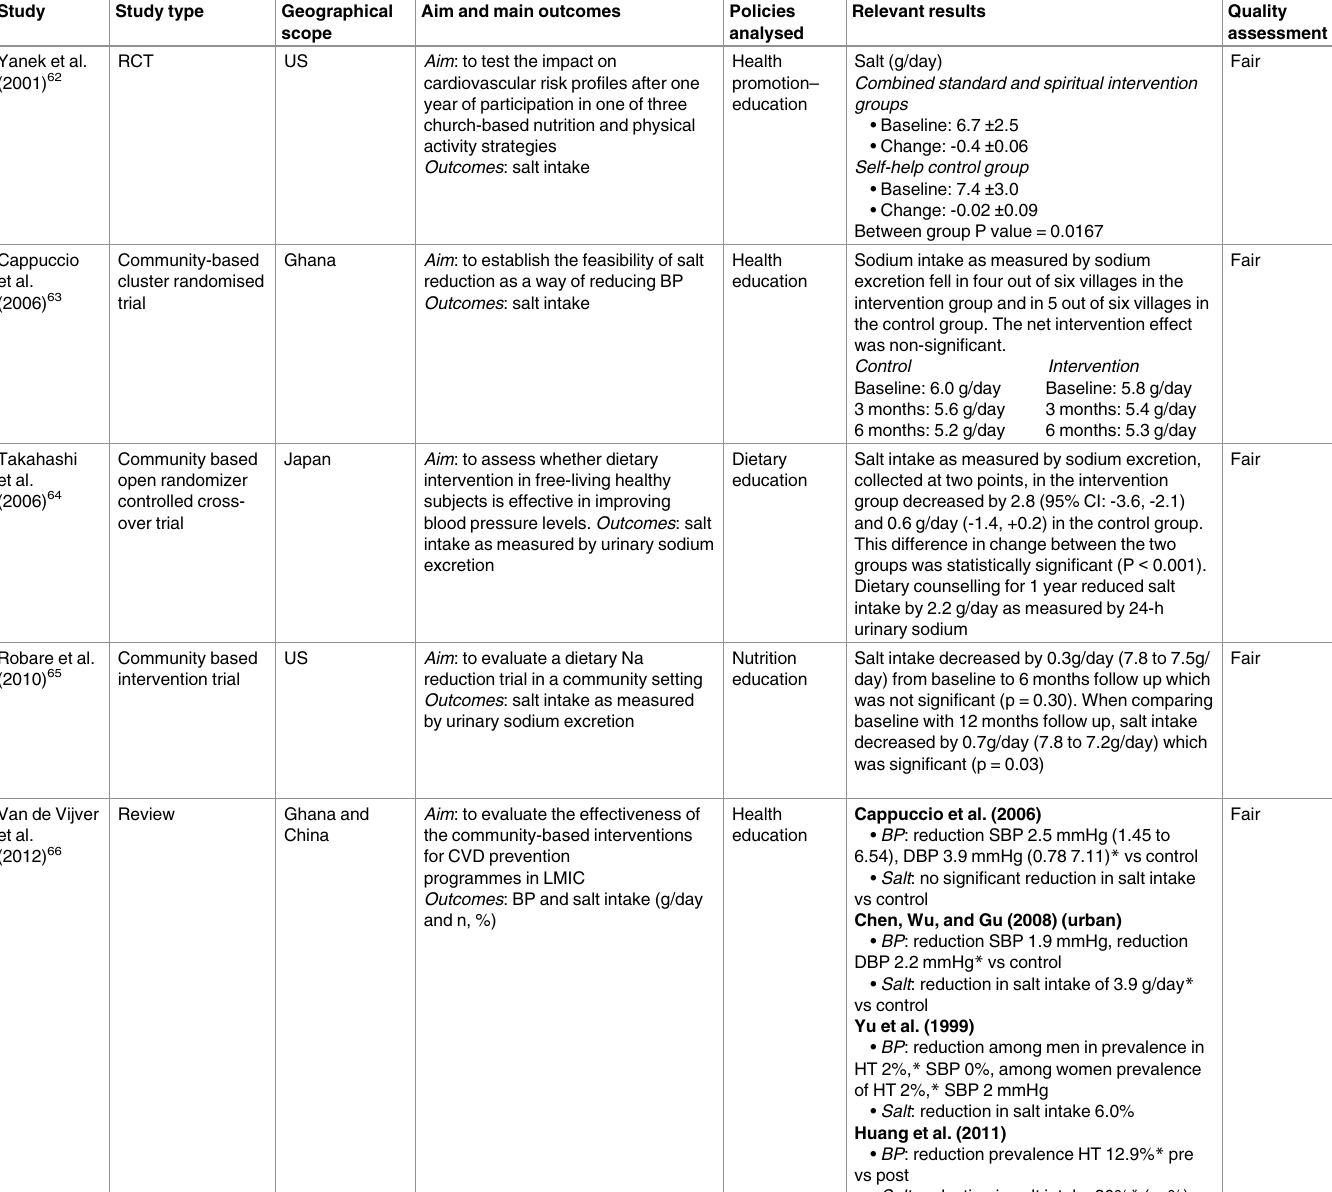
Table 4. Dietary counselling